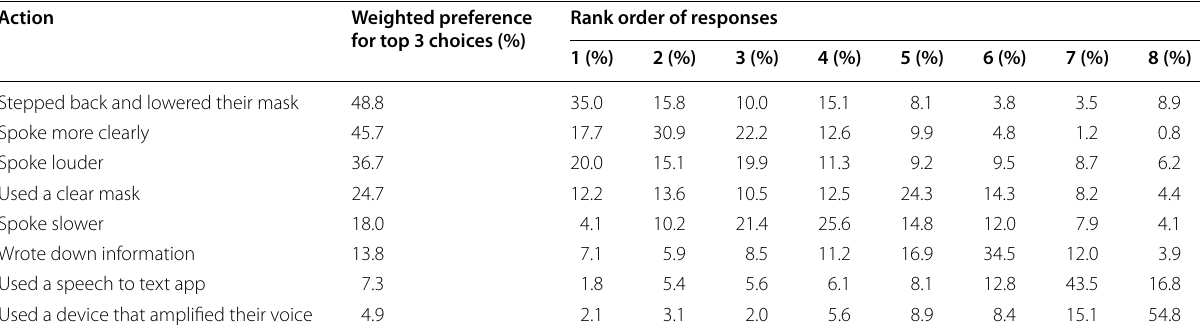
Table 2 Rank ordered communication strategies that those wearing masks could do to make understanding them easier